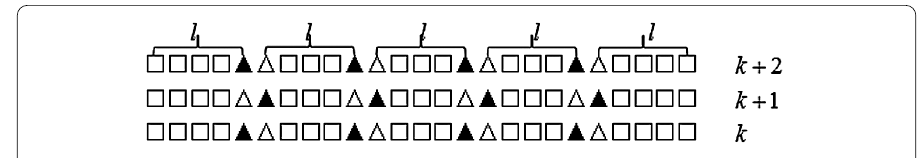
Figure 1 Schematic diagram of the IASC–N scheme ( B = 5)